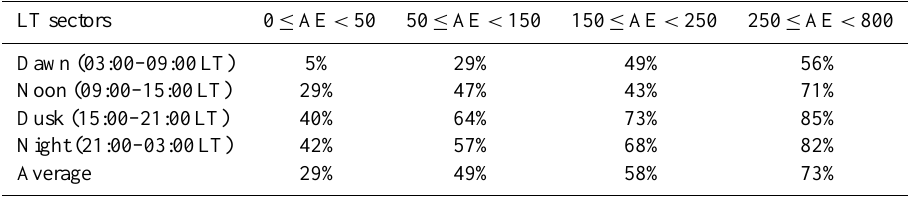
Table 3. The penetration ratio ρ of IBIPS inside geosynchronous orbit in four local time sectors for different AE bins.